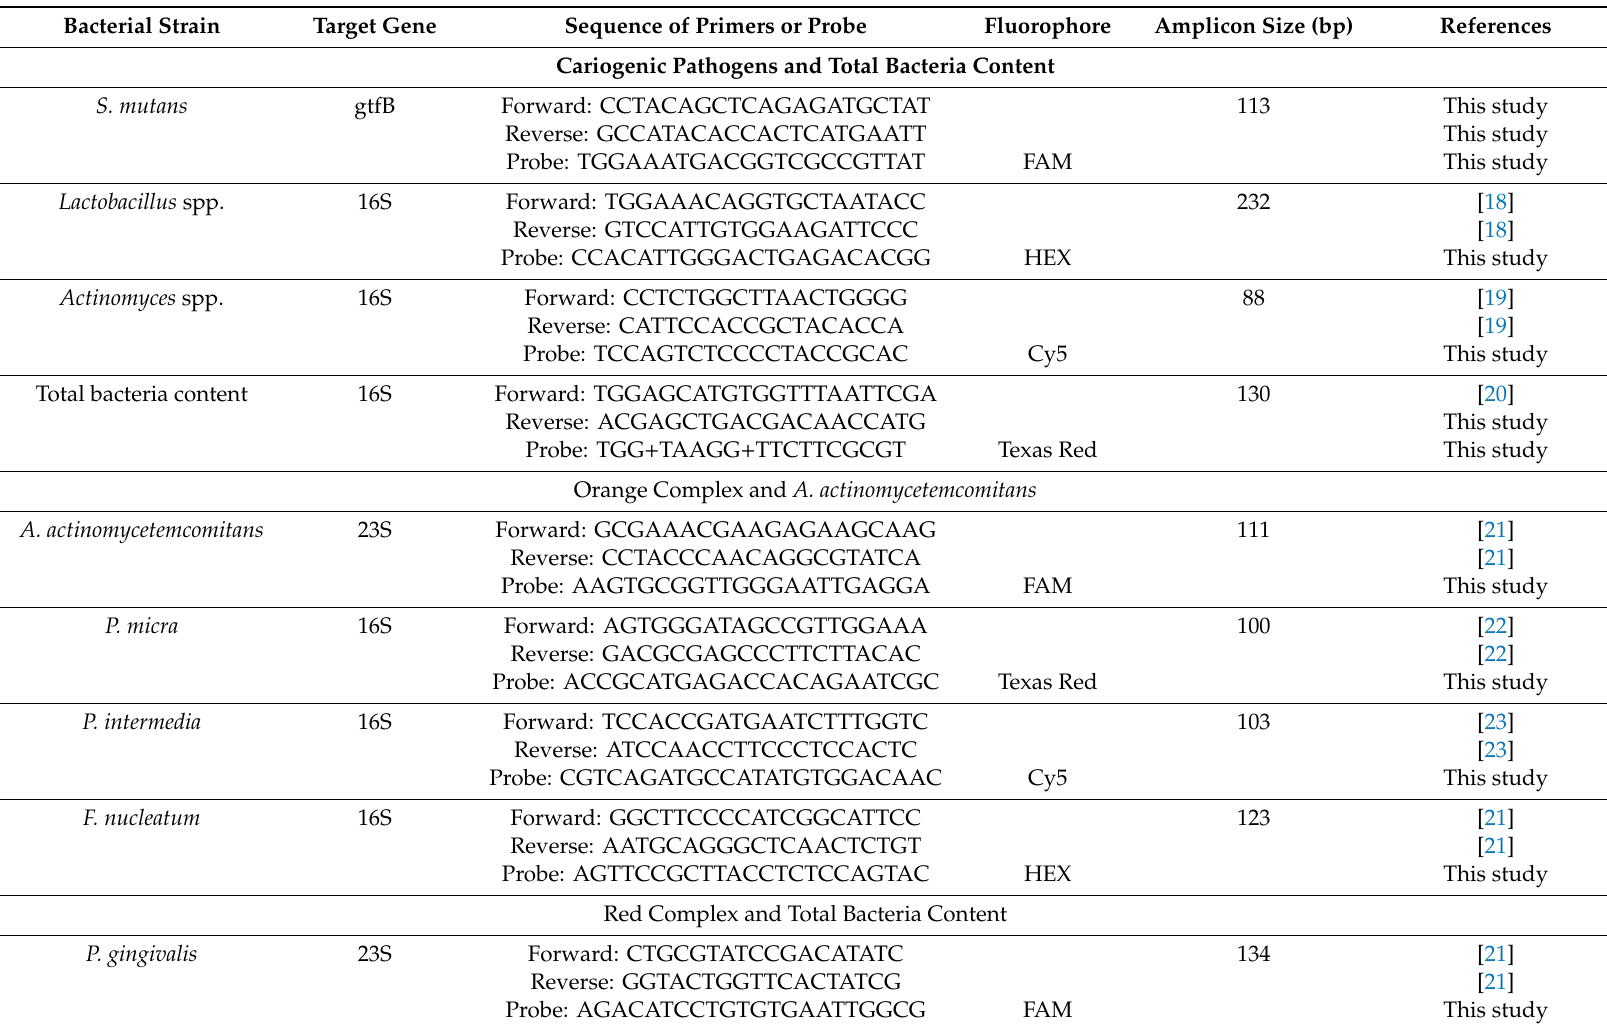
Table 1. Primers and TaqMan probes used in multiplex real-time